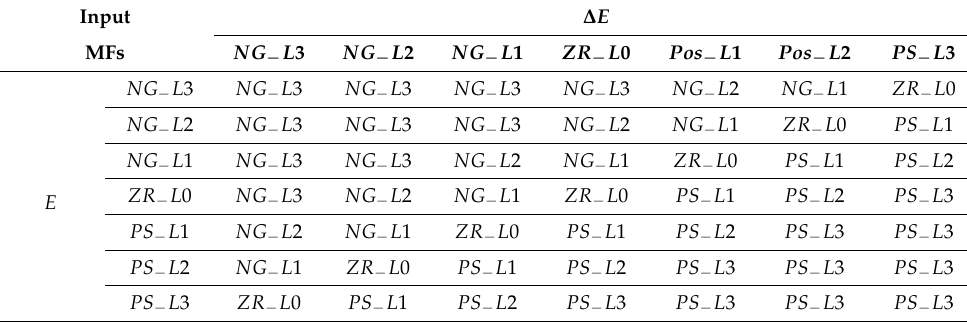
Table 1. The designed rules of the proposed FLC MPPT